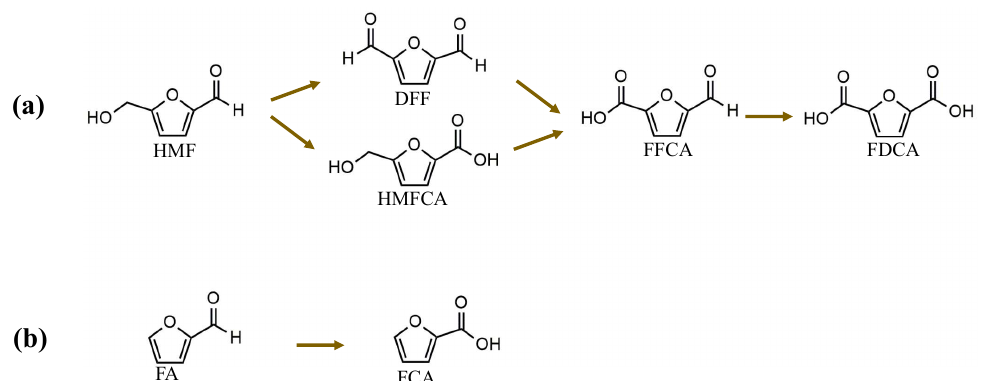
Figure 3. Schematic representation of oxidation of furan-derivatives that have been reported in the literature ( a ) HMF to FDCA, ( b ) FA to FCA. HMF : 5-hydroxymethylfurfural, DFF : furan-2,5- dicarbaldehyde, HMFCA : 5-hydroxymethyl-2-furancarboxylic acid, FFCA : 2,5- formylfurancarboxylic acid, FDCA : 2,5-furandicarboxylic acid, FA : furfural, 2-furaldehyde, FCA : 2-furancarboxylic acid or furoic acid.